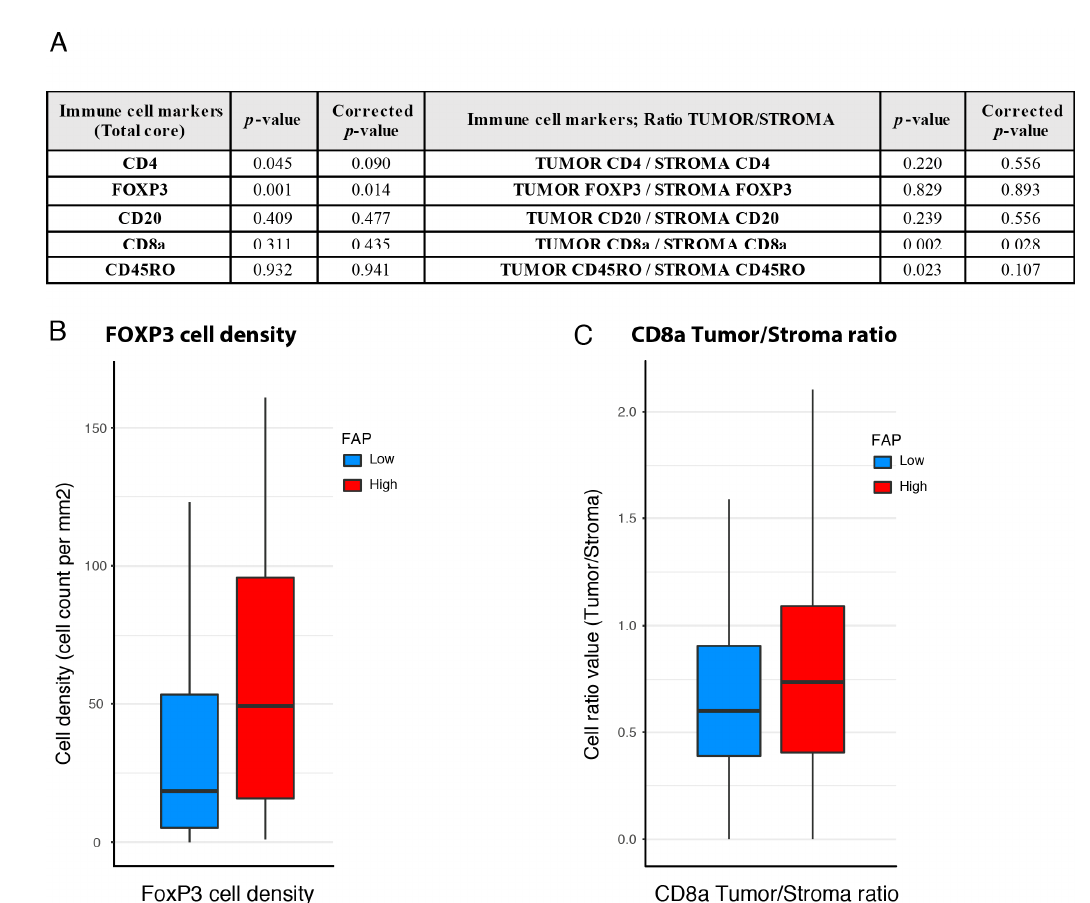
(Figure 3; p = 0.034; Log-rank test) and of CD8a density in the FAP intensity high-group (Figure 3; p = 0.042; Log-rank test). As in the U-CAN cohort, statistically significant interactions were detected between the two markers using nonadjusted analyses ( p = 0.048) (Table S8). A trend for interactions was observed in adjusted analyses also, including, age, stage, MMR status, adjuvant treatment, location, di ff erentiation and gender ( p = 0.093) (Table S8).